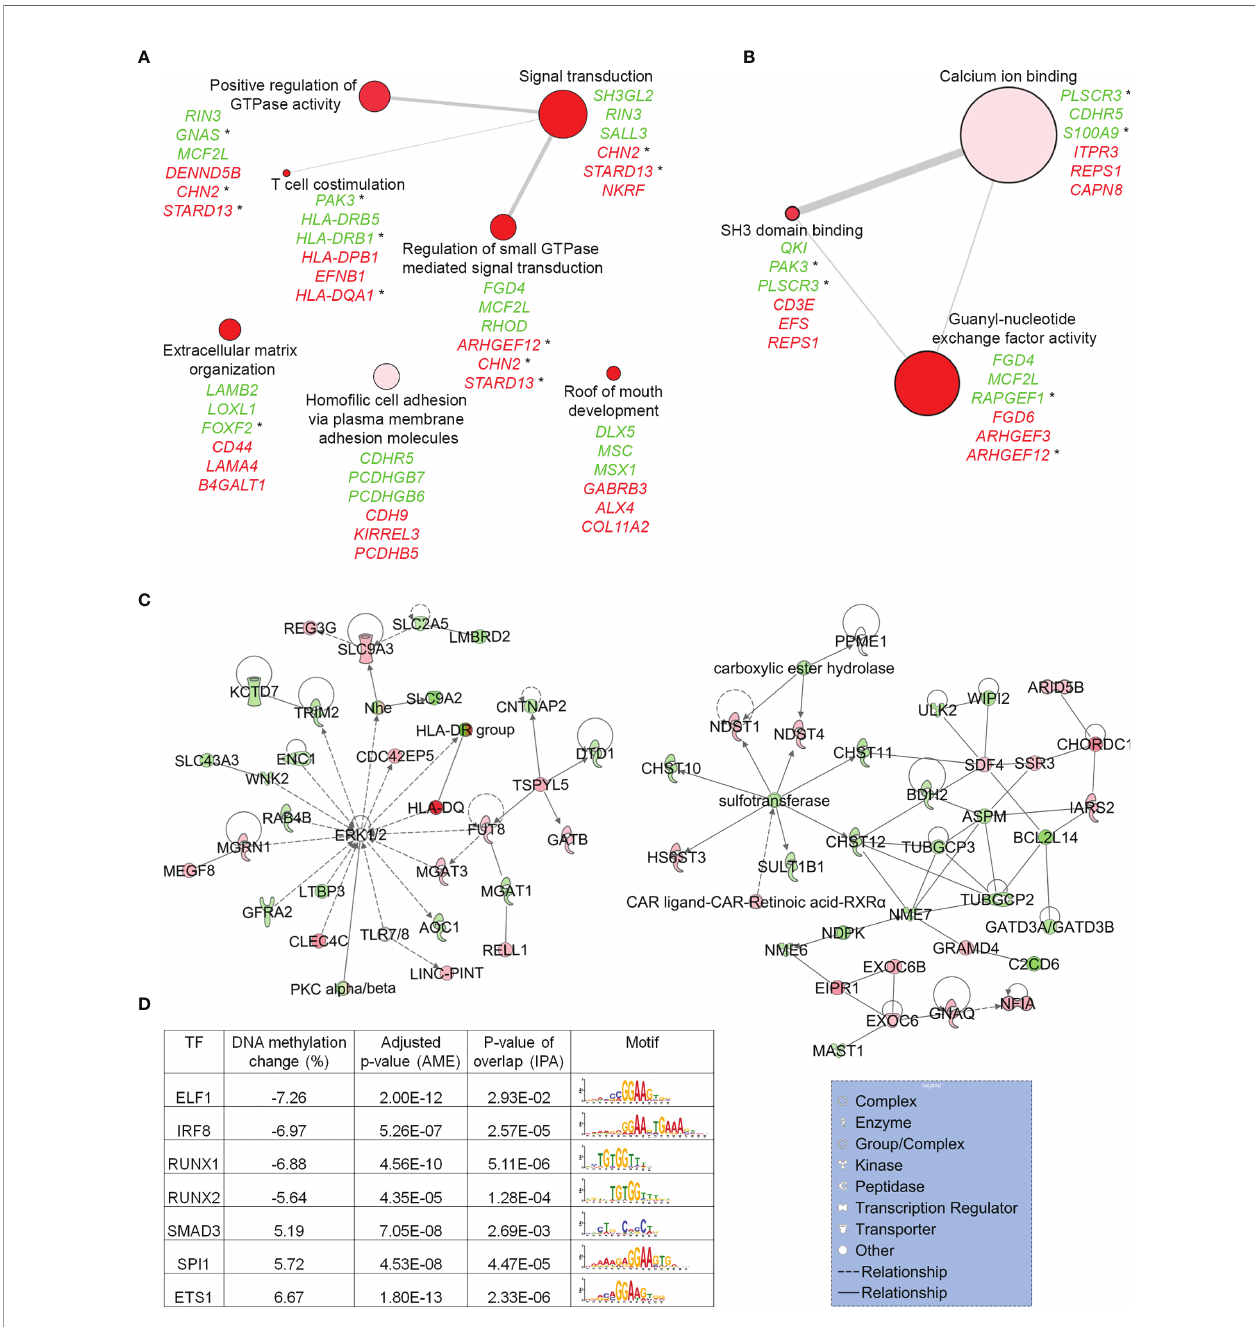
FIGURE 3 | In silico enrichment analyses of genes that associate DNA methylation changes between subjects with MUHO, compared to controls with MHO. Top scoring biological processes (A) and molecular functions (B) enriched in genes that associate DNA methylation changes above the cut-off of 5%. For each GO term, top three genes with the highest levels of DNA methylation changes are shown (loss of DNA methylation in green and gain of DNA methylation in red). Genes with an associated * have been previously been connected with regulation of glucose homeostasis (see Supplementary Table 5 ). The size of each bubble indicates the frequency of the GO term in the GOA (Gene Ontology Annotation) database. Lines connecting GO terms indicate relatedness and the line width indicates the degree of similarity. (C) IPA networks signi fi cantly enriched in genes implicated in carbohydrate metabolism (see also Supplementary Table 6 ). Green and red depict genes that associate DNA methylation loss and gain, respectively, in individuals with MUHO. Solid lines represent direct interactions between the two gene products and dotted lines mean that there is an indirect interaction. The legend shown under the second network indicates the type of protein encoded by each gene. (D) TFs that associate DNA methylation changes in individuals with MUHO and with signi fi cant enrichment of binding sites at genes harbouring differentially methylated CpGs, as determined by AME and IPA analyses. Data derived from studies (60, 62, 63, 65,